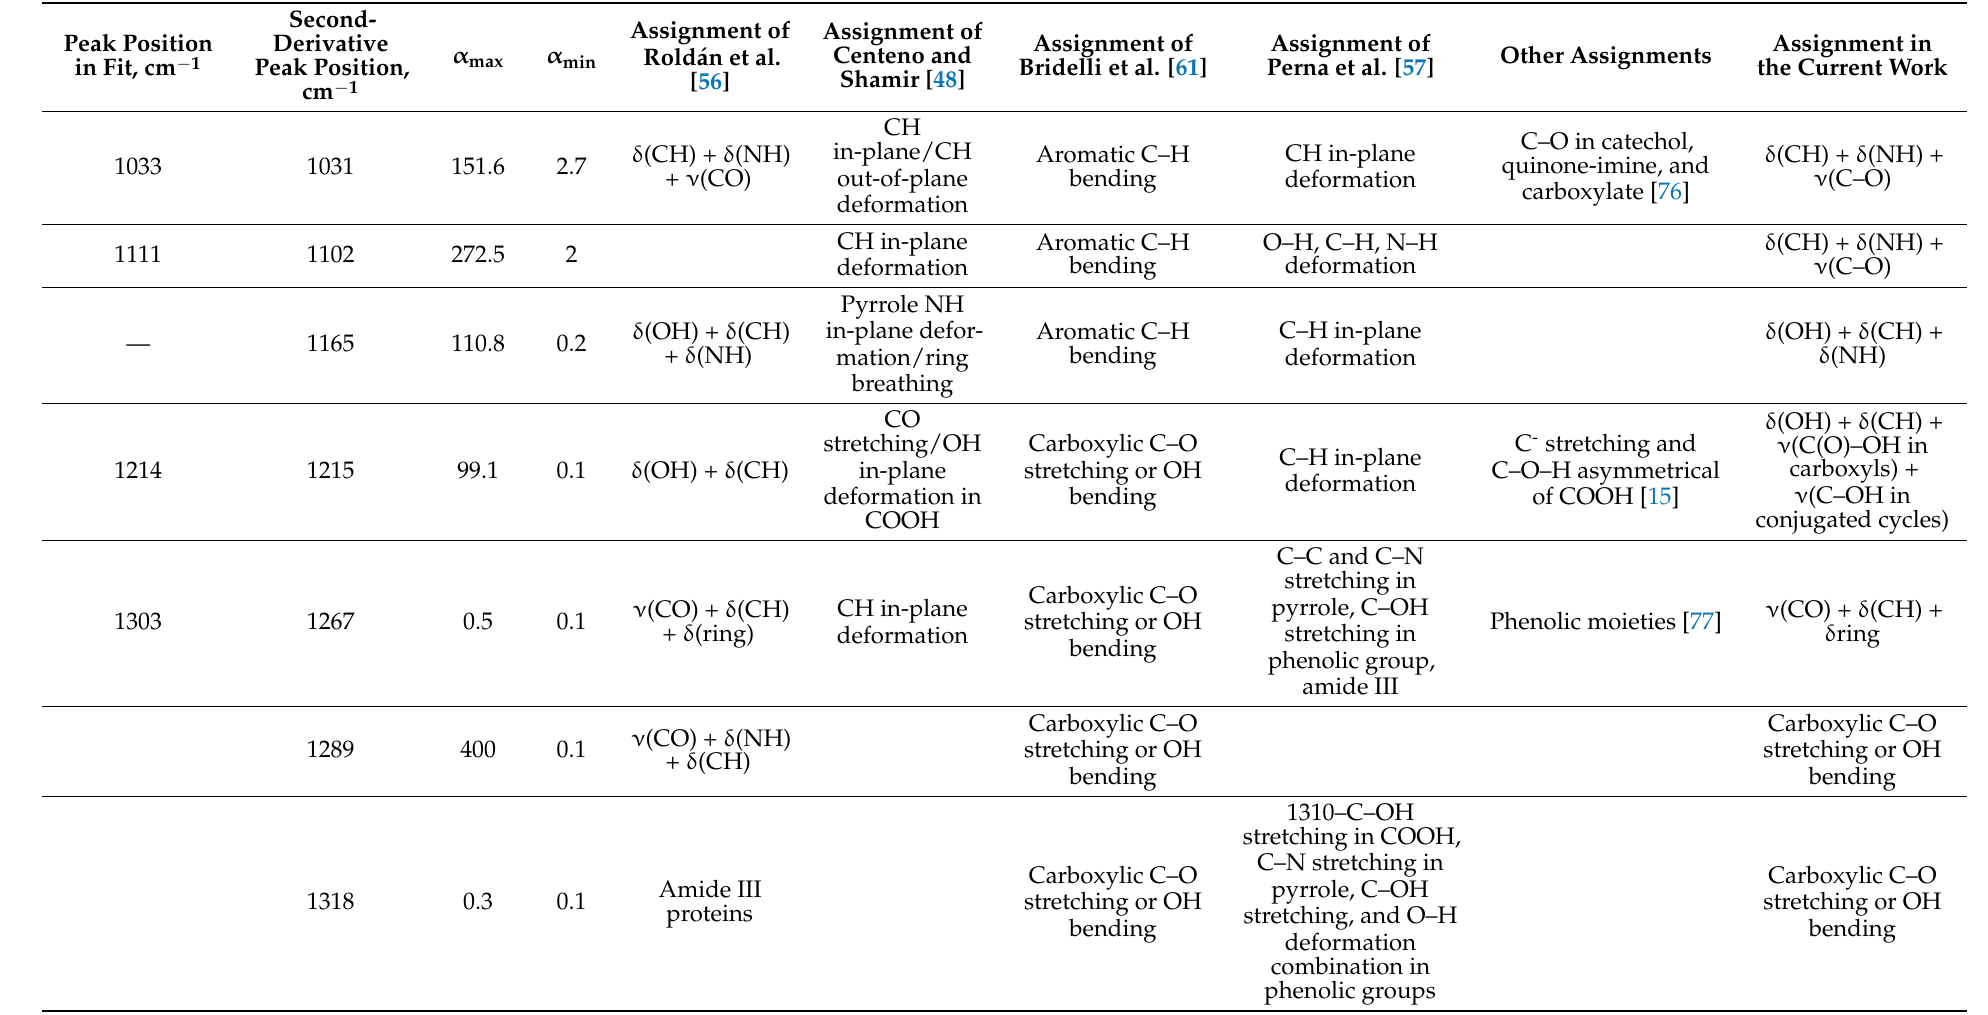
Table 3. The list of the observed excitations with a peak position in the fitting model, the corresponding position of the peaks in the second-derivative graph, the maximum and minimum value of α when the peak in SD is still visible, and the modes’